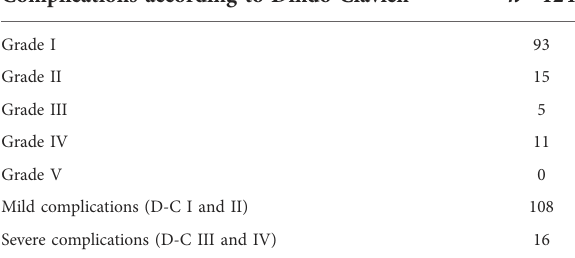
TABLE 3 Total complications according to the dindo-clavien classi fi